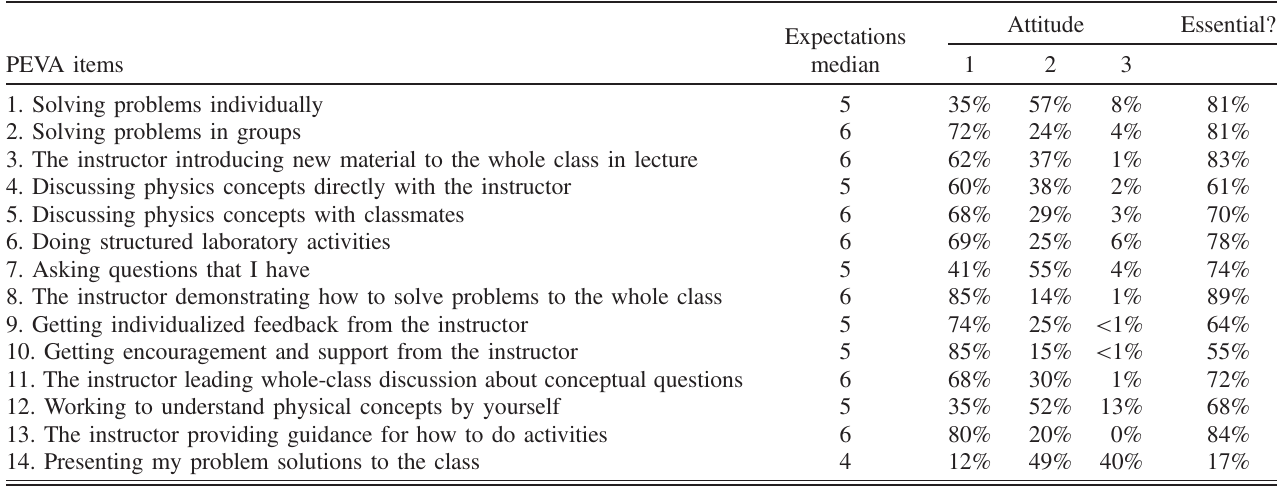
TABLE V. Students ( N ¼ 205 ) reported their expectations at week 2 about how frequently certain activities will occur in the classroom (a rating of 7 means, almost constantly; a rating of 1 means, almost never), their attitude toward those activities (1 means, it is enjoyable; 2 means, I don ’ t enjoy it but I don ’ t mind it; 3 means, I do not enjoy it and I don ’ t like when we do it), and whether they feel those activities are essential (reported is the percent of respondents to the attitude survey selecting the activity as essential).